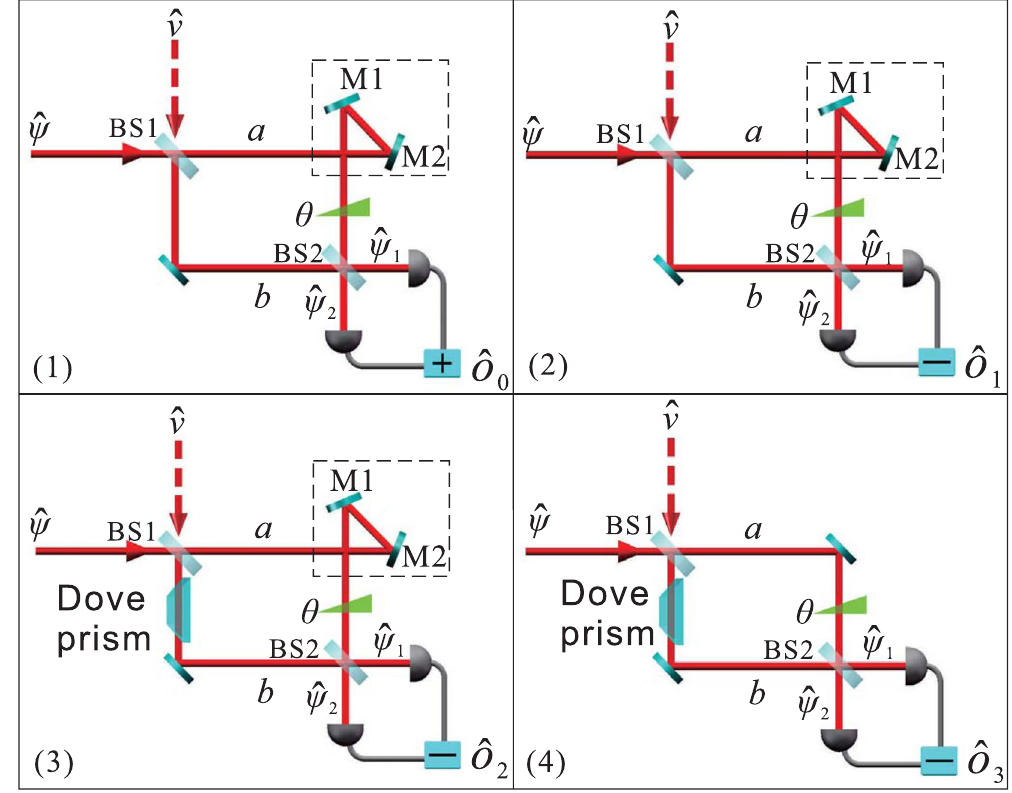
Figure 3. Detection scheme for the four orbital Stokes operators